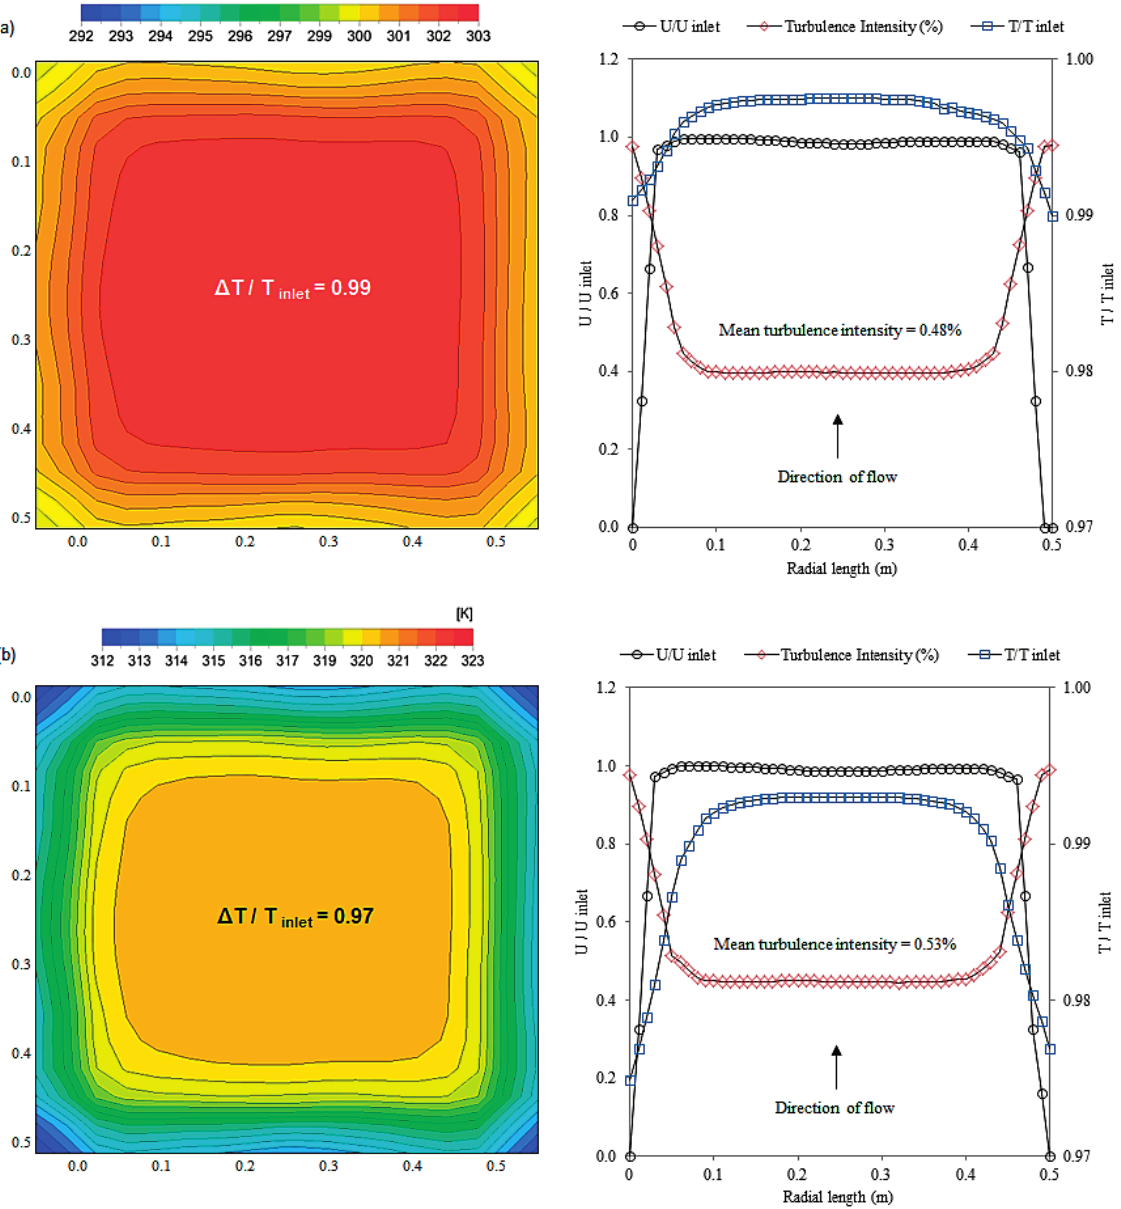
Figure 8. Temperature, turbulence and velocity distribution in the test-section at ( a ) 303 K (30 °C) and ( b ) 323 K (50